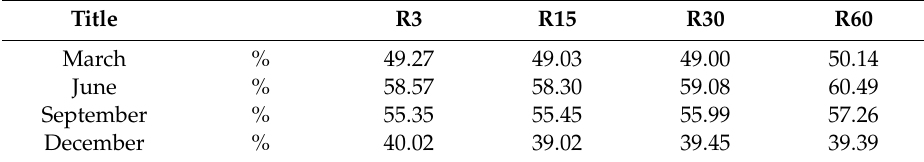
Table 8. Utilization rate of the storage system.